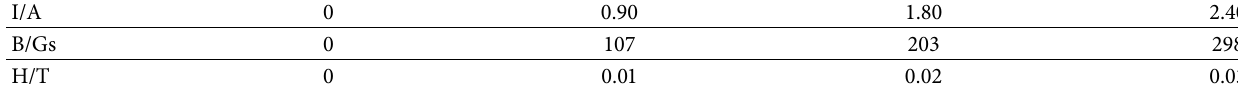
Table 2: The relationship between current and magnetic field intensity.